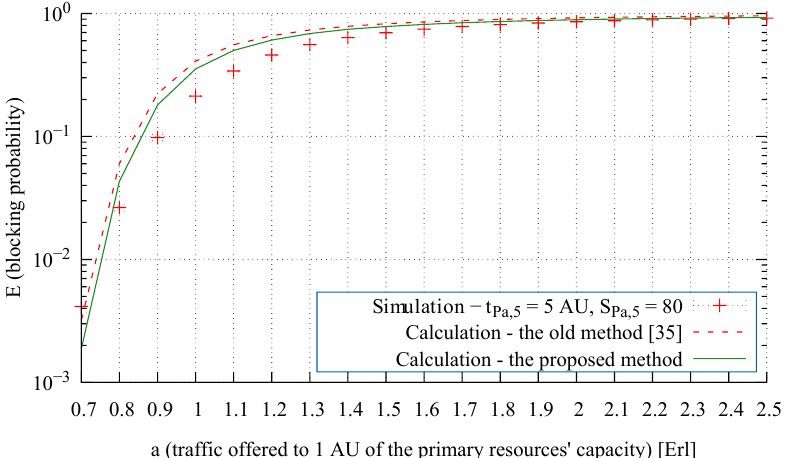
Figure 12. Blocking probability of the Pascal traffic class t Pa,3 = 2 in the secondary resources in System 2.